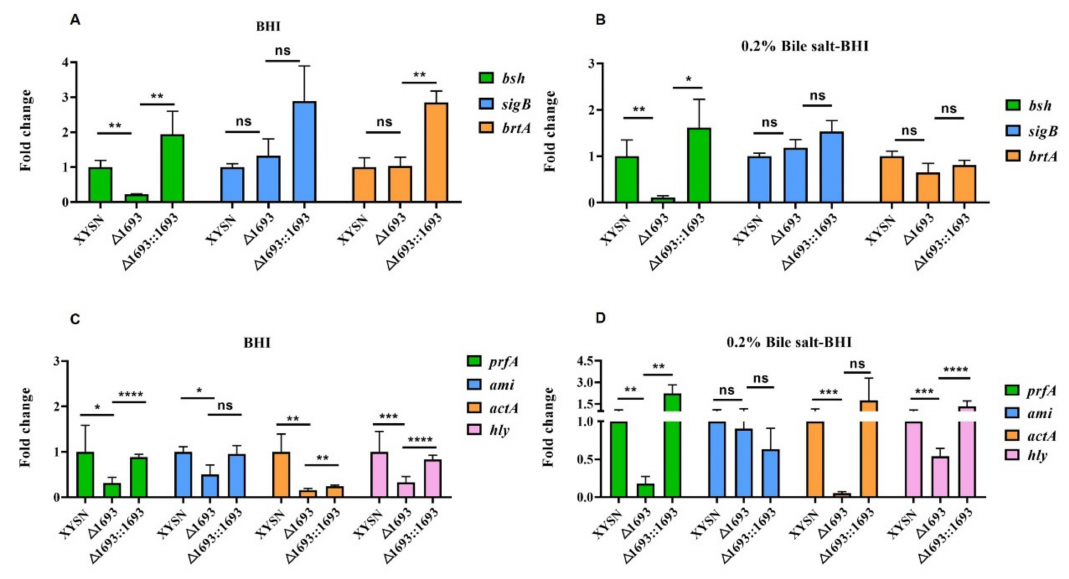
Figure 4. The expression of bile salt resistance genes and virulence genes by qRT-PCR. The tran- scriptional expressions of bile salt resistance genes were determined in BHI medium and 0.2% bile salt-BHI medium ( A , B ). The transcriptional expressions of virulence genes were determined in BHI medium and 0.2% bile salt–BHI medium ( C , D ). Error bars represented SD, n = 3 independent experi- ments. Statistical analysis was carried out by Student’s t -test: ns, no significance; * p < 0.05, ** p < 0.01, *** p < 0.001, **** p < 0.0001.